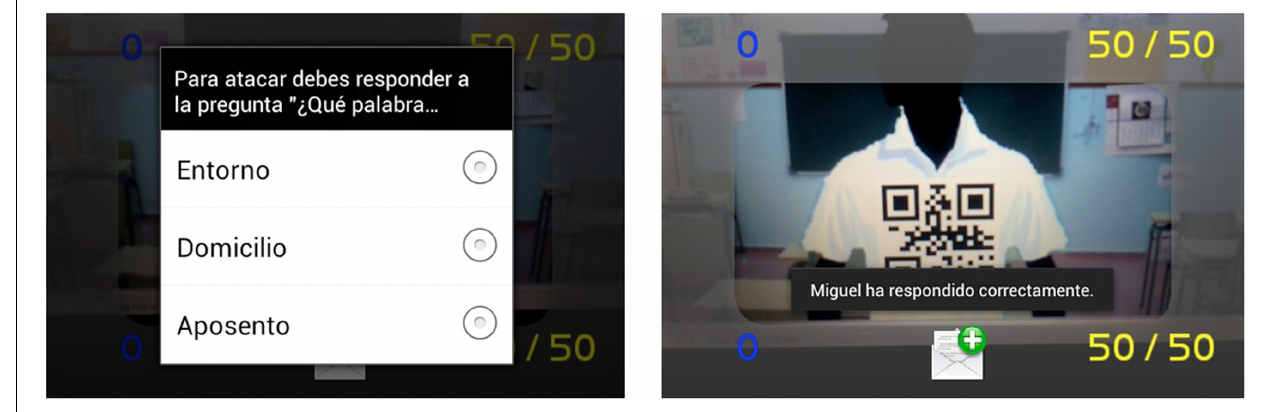
FIGURE 10 | Cancelation of an expulsion by the student #0012.